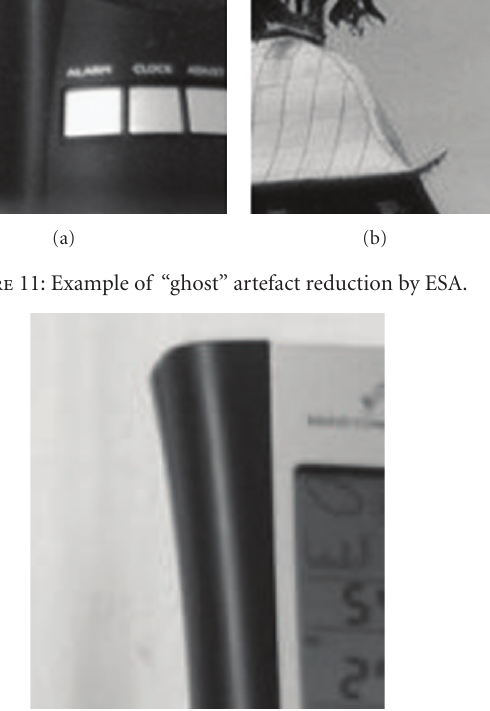
Figure 12: Example of “lakes” artefact reduction by